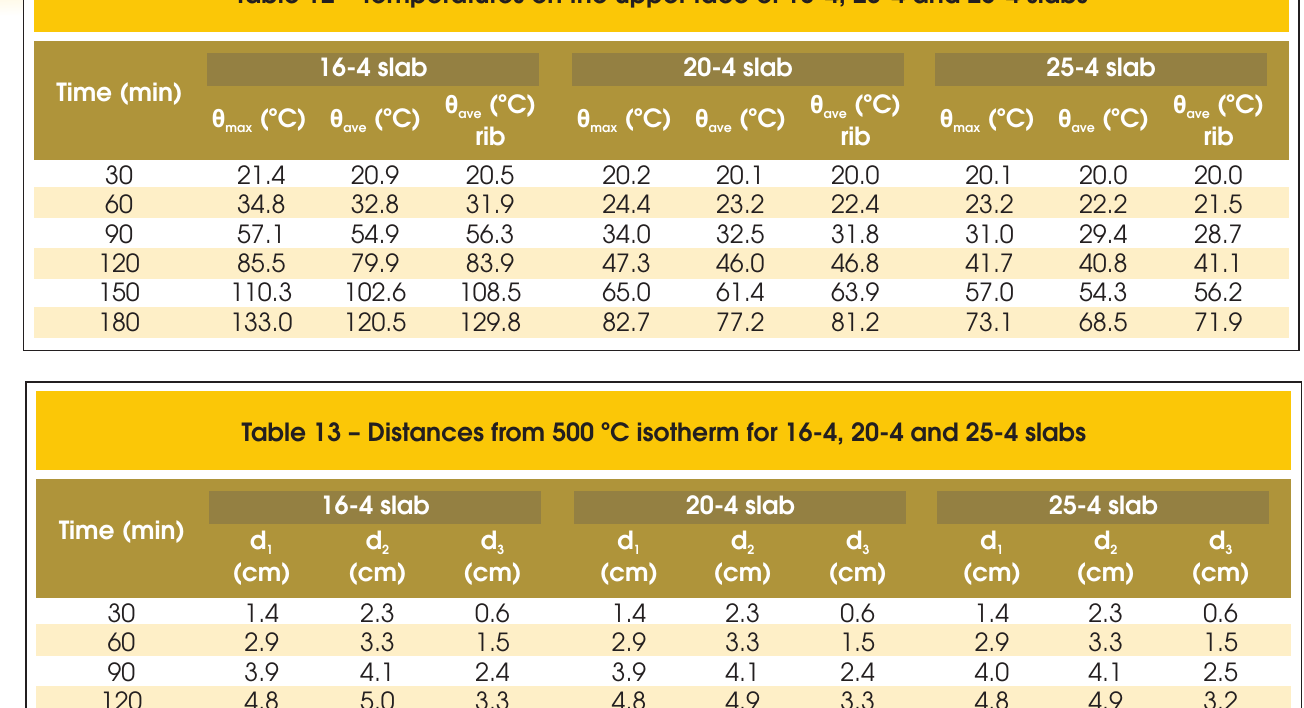
Table 12 – Temperatures on the upper face of 16-4, 20-4 and 25-4 slabs